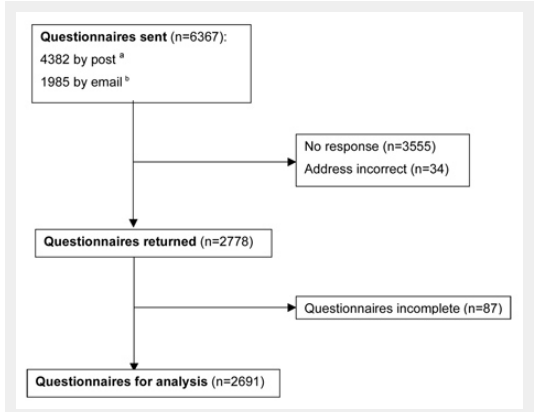
Study scheme of patients included in the analysis. a 3,201 nurses, 447 domesic staff, 388 laboratory staff, 123 physiotherapists, 108 radiographers, 51 porters, 41 occupational therapistes, 14 pathology assistants, 3 adminstrative staff. b 1,667 doctors, 318